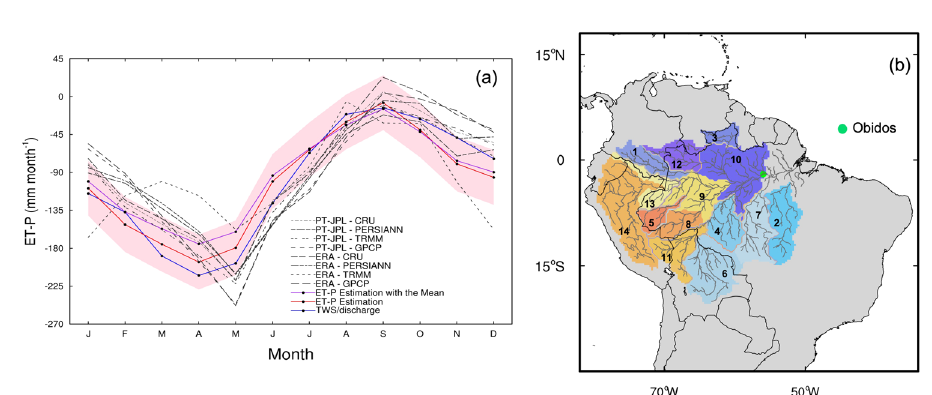
Fig. 3 The seasonality of evapotranspiration minus precipitation (ET-P) in one of the Amazon sub-basin groups and the Amazon basin distribution. a The seasonality of ET-P is from different ET and P data sources, TWS/discharge, and ET-P estimates based on AIRS δ D _004 for the geographic area composed of river basins 3, 10, and 12 (Group 1; “ Methods ” ) during 2003 – 2015. Panel b shows the river basin distribution map for the Amazon. In a , we use area-weighted averaging. We use two ET sources; one is from PT-JPL ET, the other is the latent heat fl ux of ERA5. We also use four precipitation products: TRMM, GPCP, PERSIANN, and CRU. Other monthly data products include terrestrial water storage (TWS) from GRACE, river discharge from Amazon river gauge measurements, and ET-P derived from AIRS δ D _004. “ ET-P Estimation ” is the ET-P estimate from AIRS δ D _004 based on the regression against TWS/discharge. “ ET-P Estimation with Mean ” is an alternative estimate of ET-P from AIRS δ D _004 based on regressing the isotopic data against the average ET-P derived from the eight combinations of remote-sensing and reanalysis moist fl ux products. The pink shading represents